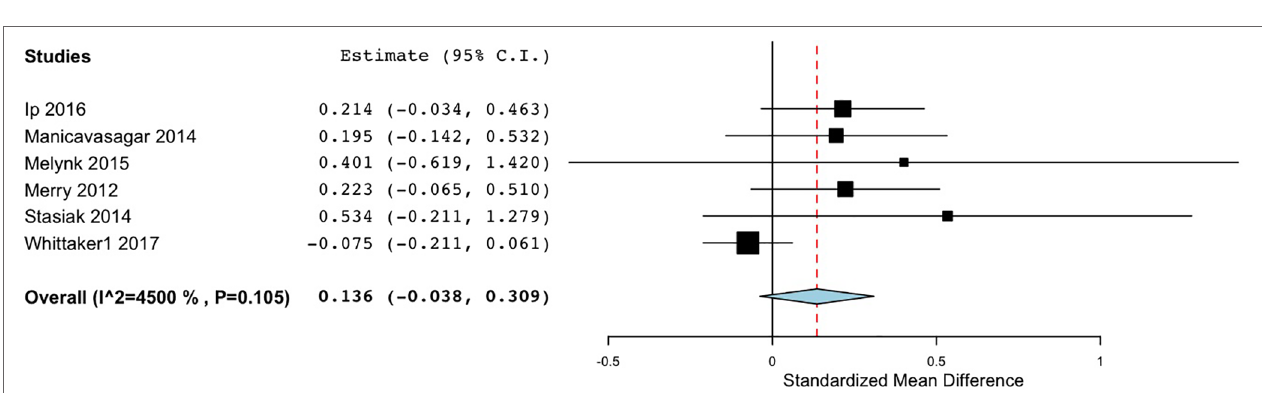
FIGURE 3 | Forest plot of meta-analysis of randomised controlled comparisons between DMHIs and active control groups for depression in